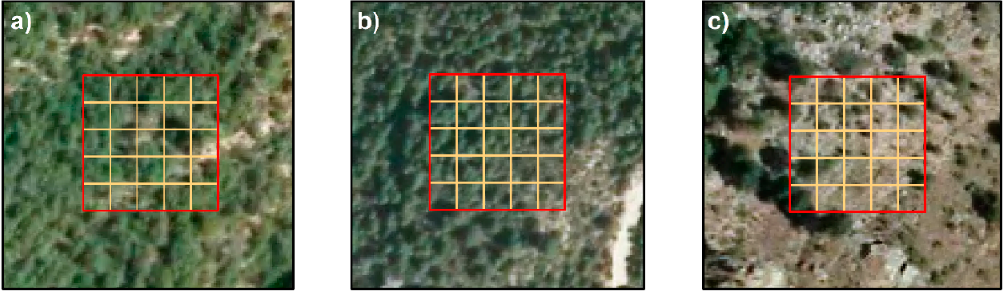
Figure 5. Examples of high resolution orthophotos of recovered ( a , b ) and non-recovered pixels ( c ) in 5 by 5 grids.